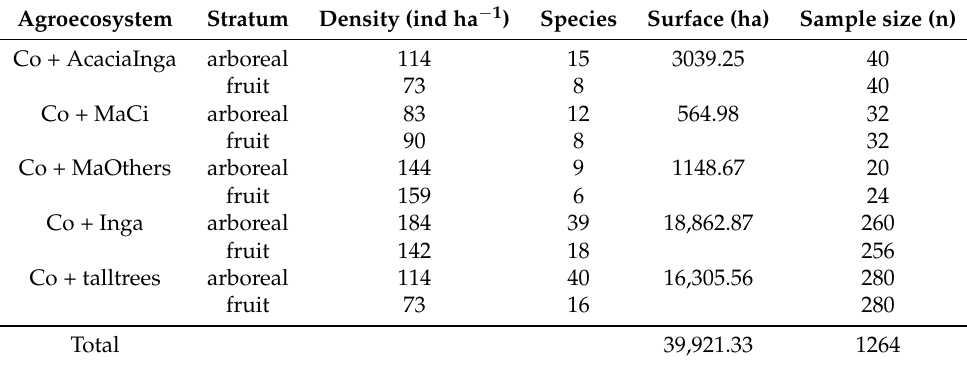
Table 3. Density and richness of species identified by type of coffee agroecosystem in the central region of Veracruz,